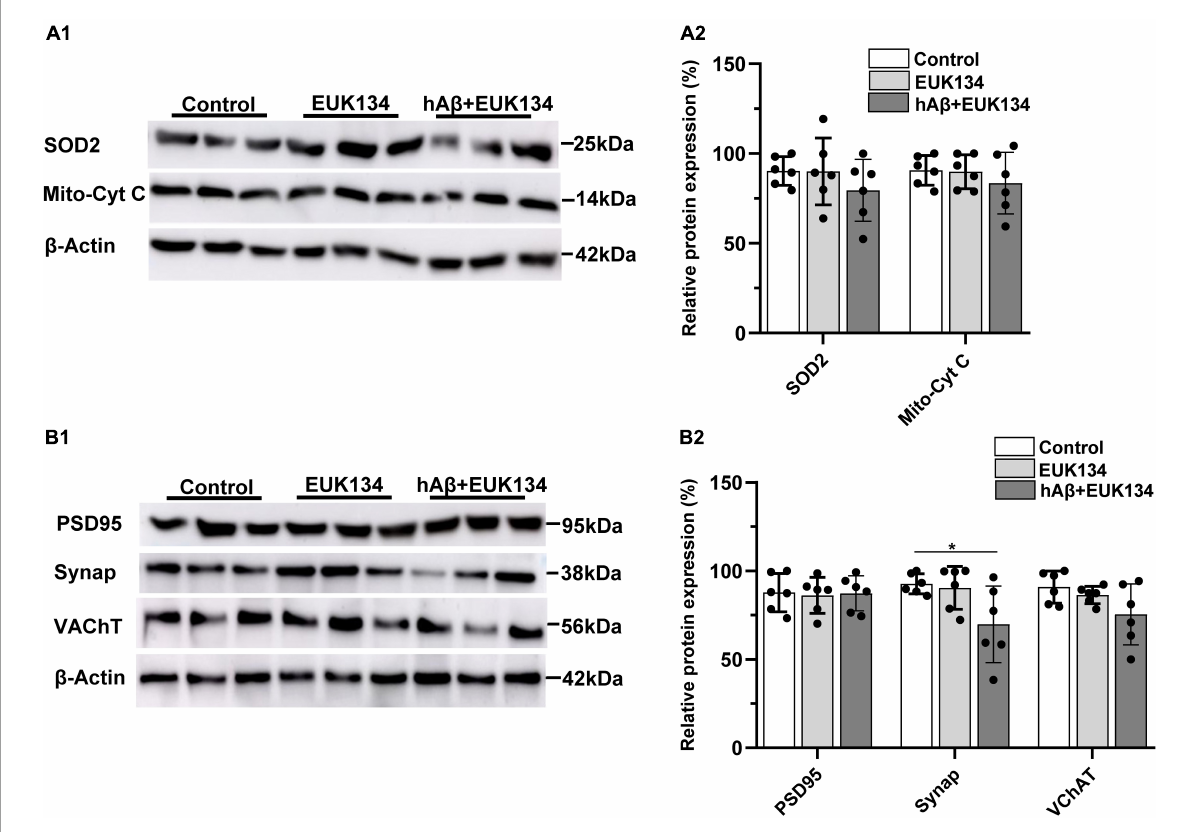
FIGURE4 Inhibiting increases in reactive oxygen species with EUK134 prevents hA β 1 − 42 -induced changes in mitochondrial and synaptic proteins. (A1) Representative immunoblots of superoxide dismutase 2 (SOD2), mitochondrial cytochrome c (Mito-cyt C), and the loading control β -Actin, are shown in slices treated with EUK134, hA β 1 − 42 with EUK134, and control. (A2) Normalized relative expression of SOD2 and Mito-cyt C proteins ( n = 6). (B1) Representative immunoblots of postsynaptic density protein PSD95, presynaptic marker synaptophysin (Synap.), vesicular acetylcholine transporter (VAChT), and the loading control β -Actin are shown for tissue treated with EUK134, hA β 1 − 42 with EUK134, and control. Bar graphs indicate normalized relative expression of PSD95, Synap., and VAChT (B2) (* p <